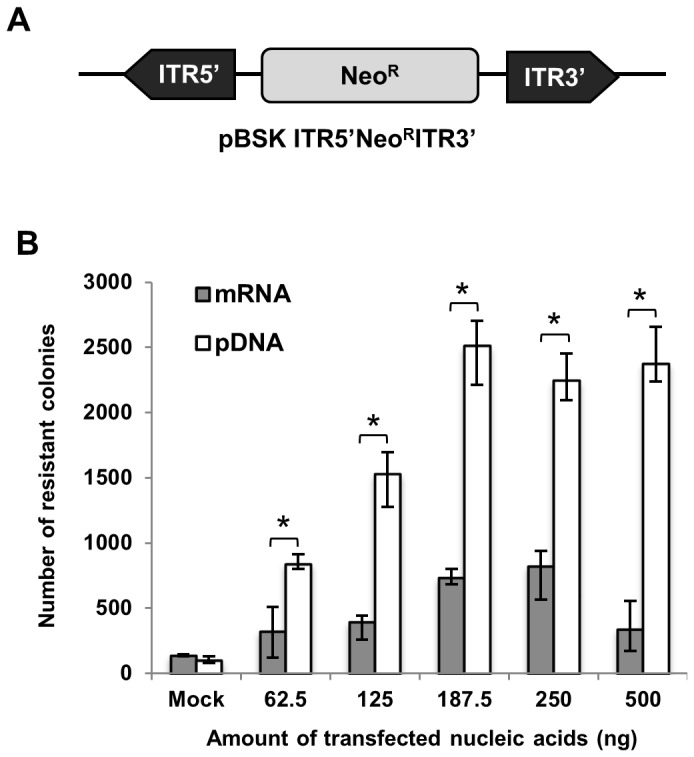
Transposition assay in mammalian cells.(A) Donor plasmid harboring the transposable element. This vector is composed of the neomycin phosphotransferase gene (NeoR) flanked by the PB ITRs. (B) Transposition efficiency by type and quantity of nucleic acid. Cells were transfected with indicated amounts of PB mRNA or pDNA alongside with 187.5 ng of donor plasmid. GFP mRNA or pDNA (500 ng) served as negative controls of transposition (Mock: recombination events). To consider only transposition events, the number of colonies observed in the presence of the transposase source was subtracted by the number of colonies obtained in the respective negative control performed without transposase for each quantity. Values represent the average of 3 experiments done in triplicate. * Represents statistically significant difference between mRNA and pDNA (p<0.05).